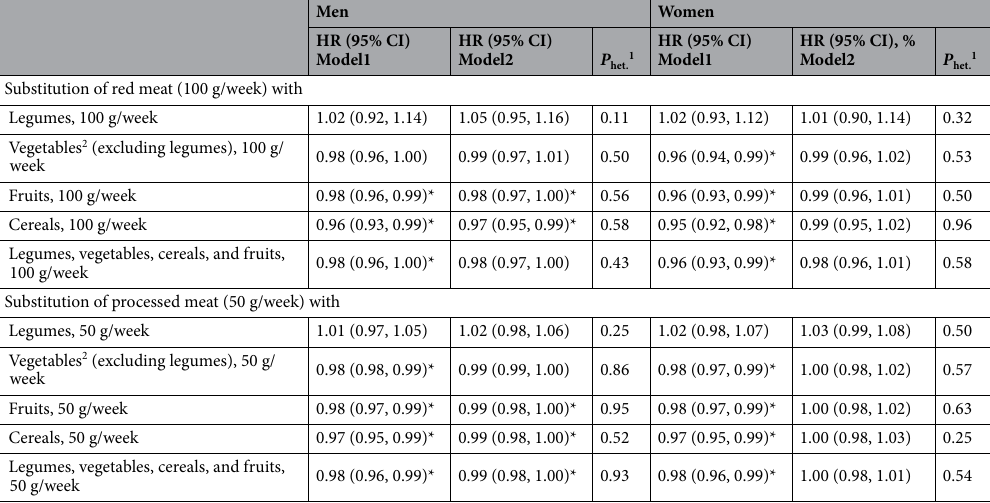
Table 3. Pooled associations between partial substitutions of red meat or processed meat with legumes, vegetables, fruits, cereals or the combination of plant-based foods and type 2 diabetes risk in men and women. Model 1: adjusted for age (years, continuous) and energy (kJ/day, continuous). Model 2: adjusted for Model 1 + education (tertiles by birth year), smoking (never, former, current), body mass index. (kg/m2,